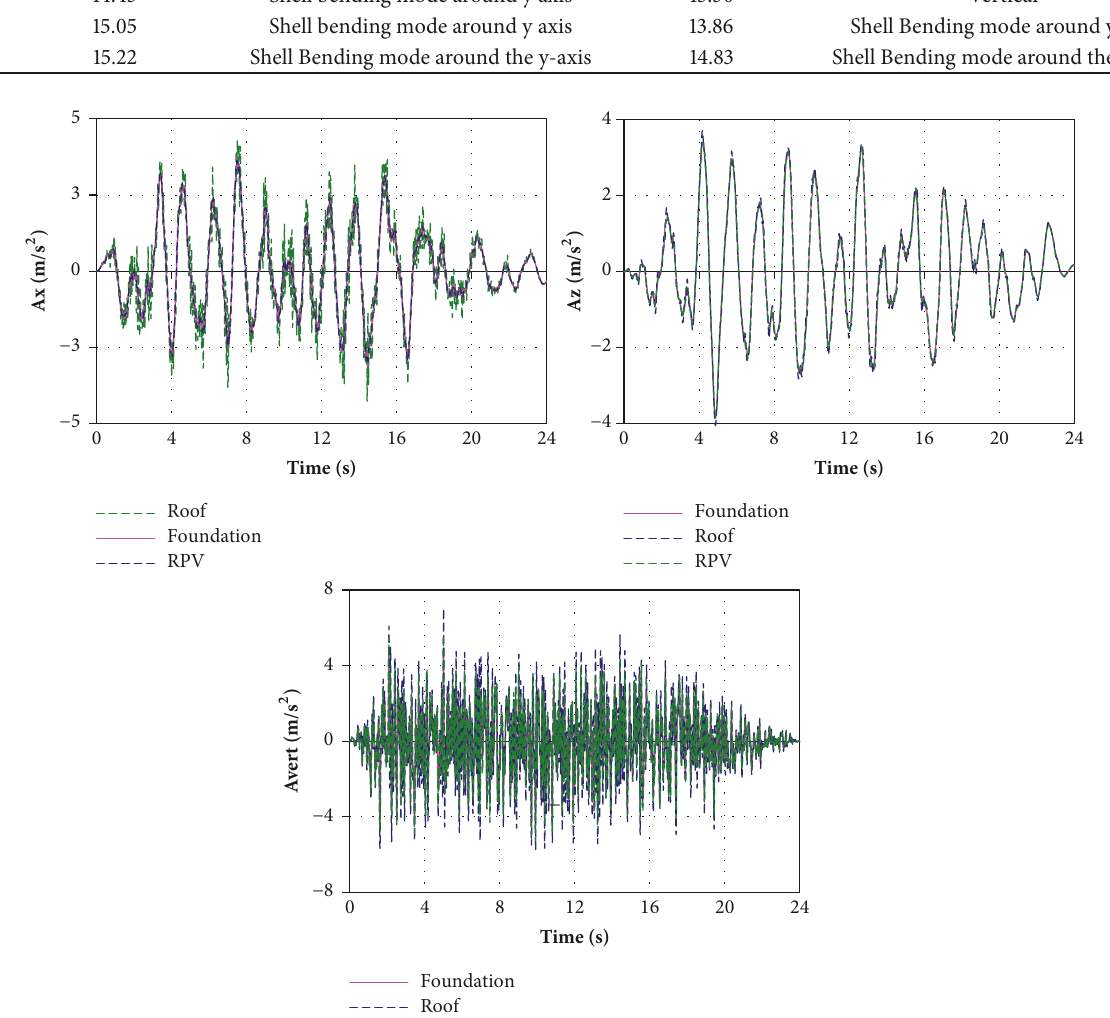
Figure 9: Acceleration trend at different elevations along the isolated containment